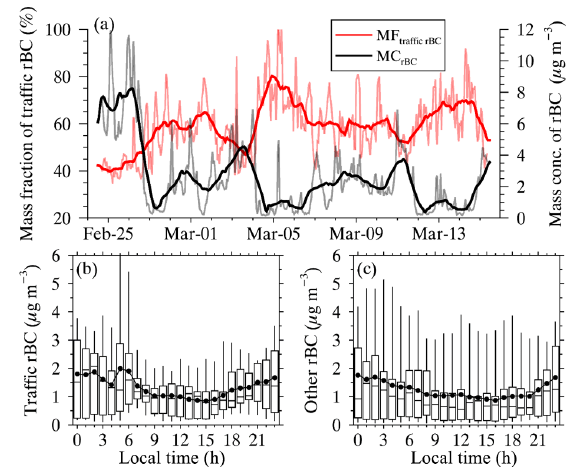
Figure 5. (a) Time series of hourly mass concentration of rBC (MC rBC ) and mass fraction of local traffic-related rBC (MF traffic ) . The bold lines represent the variations of the daily moving averaged MC rBC and MF traffic . Panels (b) and (c) show the diurnal varia- tions in the decomposed rBC from local traffic emission and other sources,